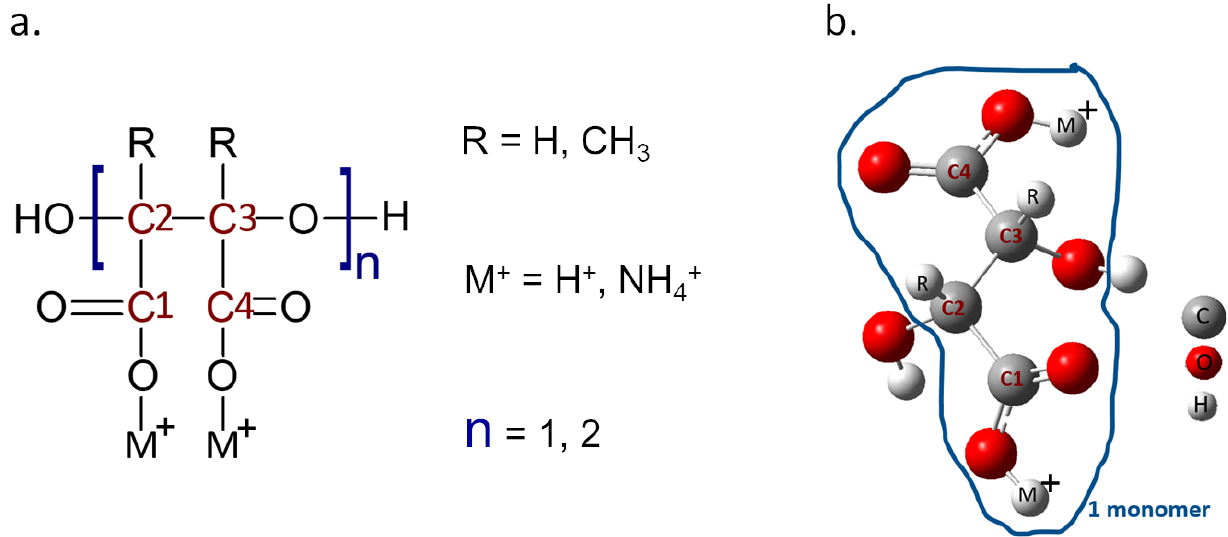
Figure 1. ( a ) Structure of PESA, highlighting the different R and M + groups. ( b ) Model of the molecule as employed in the simulations.